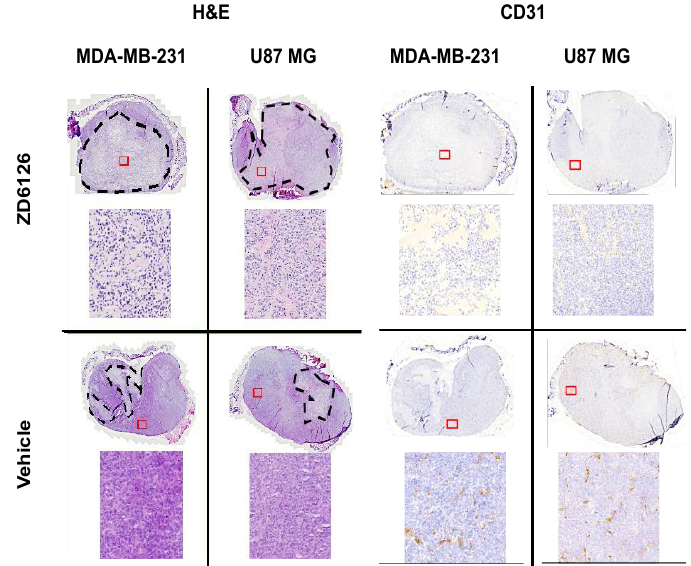
Figure A2. Box plots and whisker plots of c s , C and GoF in MDA-MB-231 tumours as measured on three consecutive days. We compared median c s , mean C and mean GoF for one and two vibrational sources (shakers) from all tumours ( n = 5). There was no significant difference in C and GoF for two vibrational sources compared to one. Median c s was greater for two shakers but not significantly so.